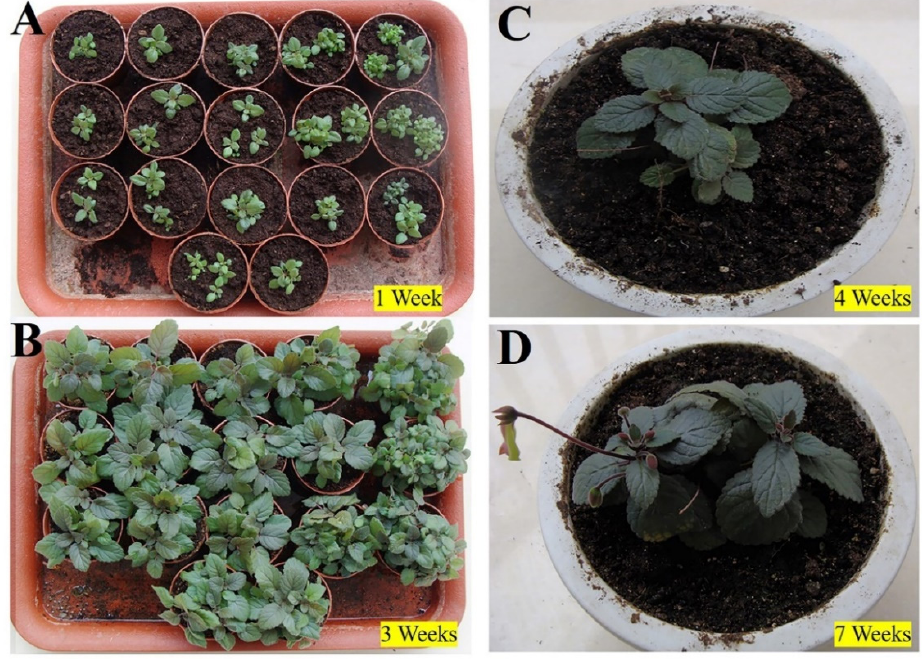
Figure 4. Acclimatization. Acclimatized plants by rooting in vitro after one week ( A ), three weeks ( B ), four weeks ( C ), and seven weeks ( D ), respectively.